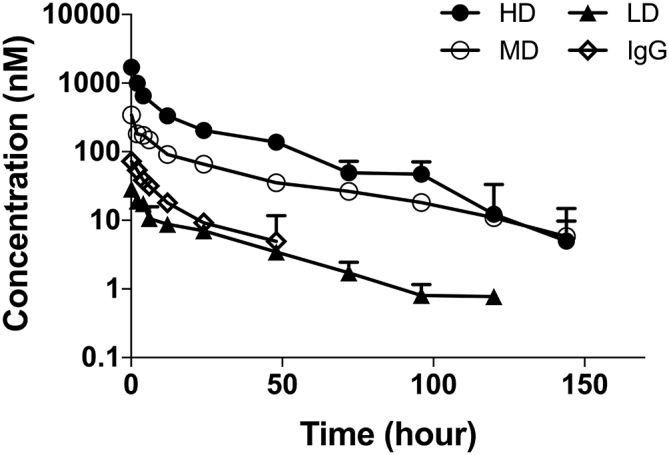
Establishing DY605-Cetuximab Pharmacokinetics In VivoProfiles of mean (±SD) plasma concentrations versus time after a single tail vein injection of 1.0 (LD), 8.5 (MD), and 50 (HD) mg/kg DY605-cetuximab or 1.9 mg/kg DY605-IgG (control) in tumor-bearing animals. The decay phases of DY605-cetuximab and DY605-IgG PK curves exhibited a similar trend. Plasma concentrations of 50 mg/kg and 8.5 mg/kg groups were below detection limits at 144 h, whereas the plasma concentration of the 1 mg/kg group fell below detection limits at 120 h. The detection limits are 15, 5, 0.7, and 3 nM for HD, MD, LD, and control groups, respectively. Each data point represents the mean value of three replicates. Error bars represent ±SD. HD = High Dose (50 mg/kg); MD = Medium Dose (8.5 mg/kg); LD = Low Dose (1.0 mg/kg).